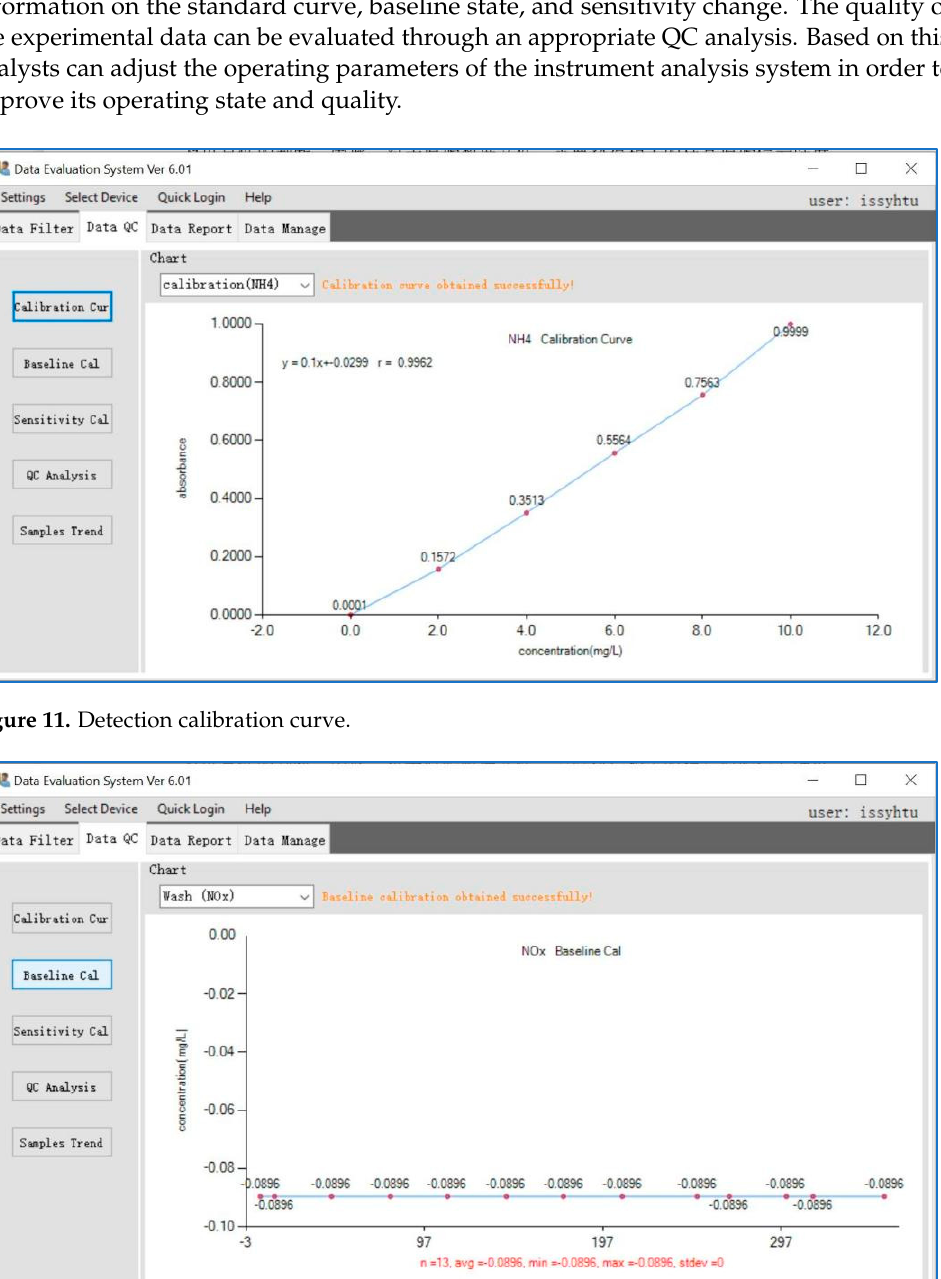
Figure 13. Sensitivity calibration of the sample data.